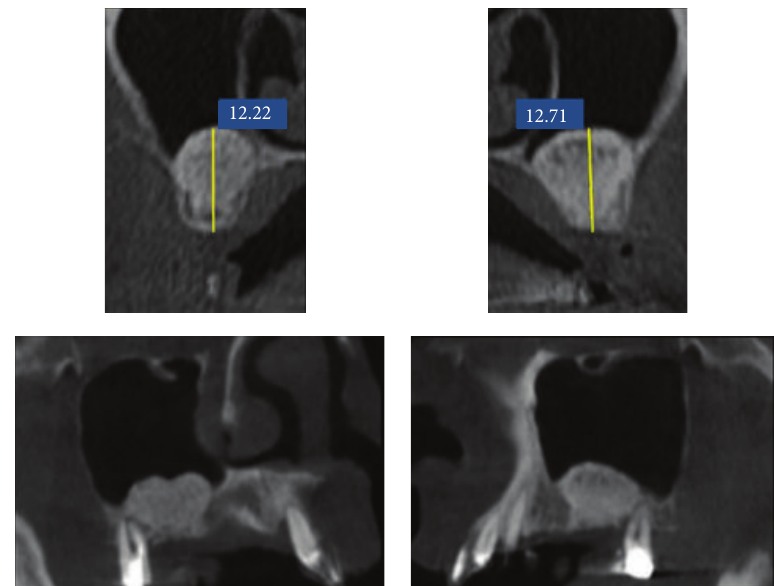
Figure 4: Radiological tridimensional evaluation of bone augmentation.